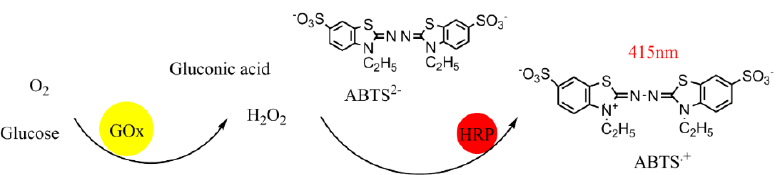
Figure 10. Schematic diagram of the color reaction system used in high-throughput screening. Using this method to test A 415nm can quickly detect the remaining concentration of glucose in the system, which can reflect the level of catalytic efficiency of each mutant.